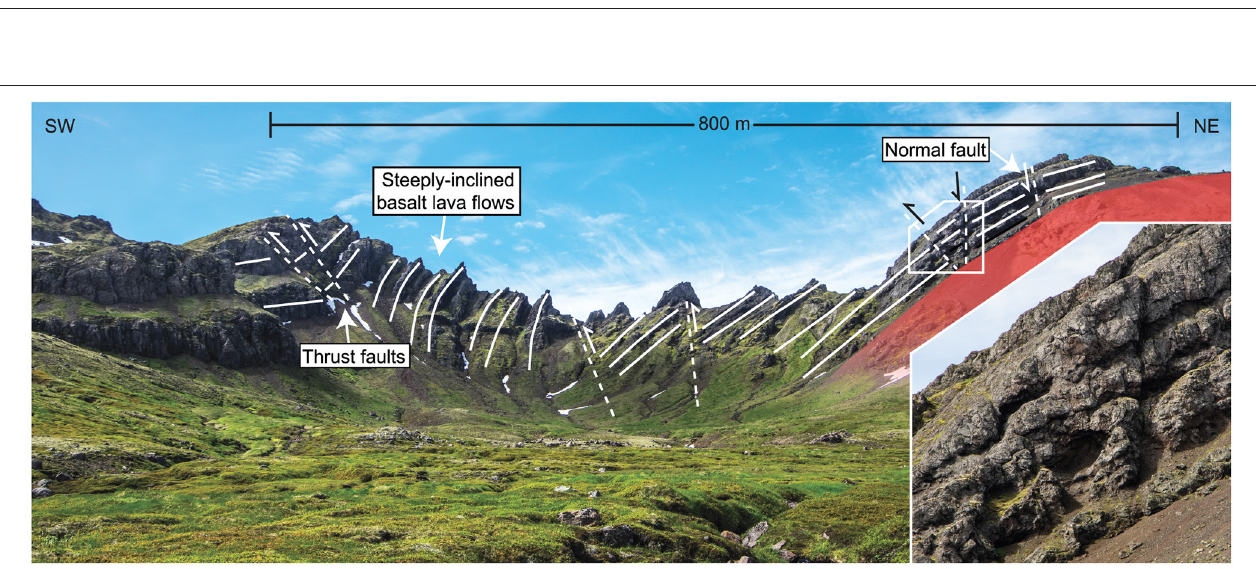
Frontiers in Earth Science | www.frontiersin.org